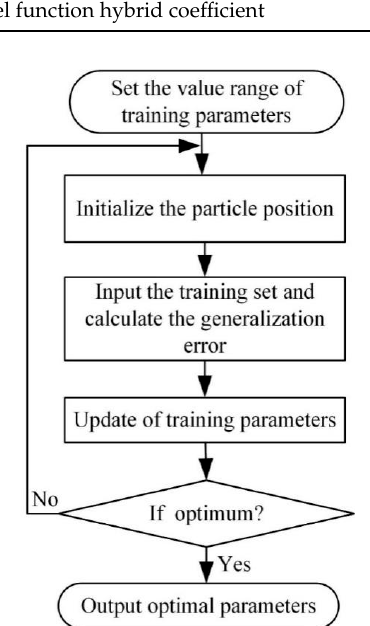
Figure 1. Flow chart of parameters optimization by Krill Herd (KH) algorithm.